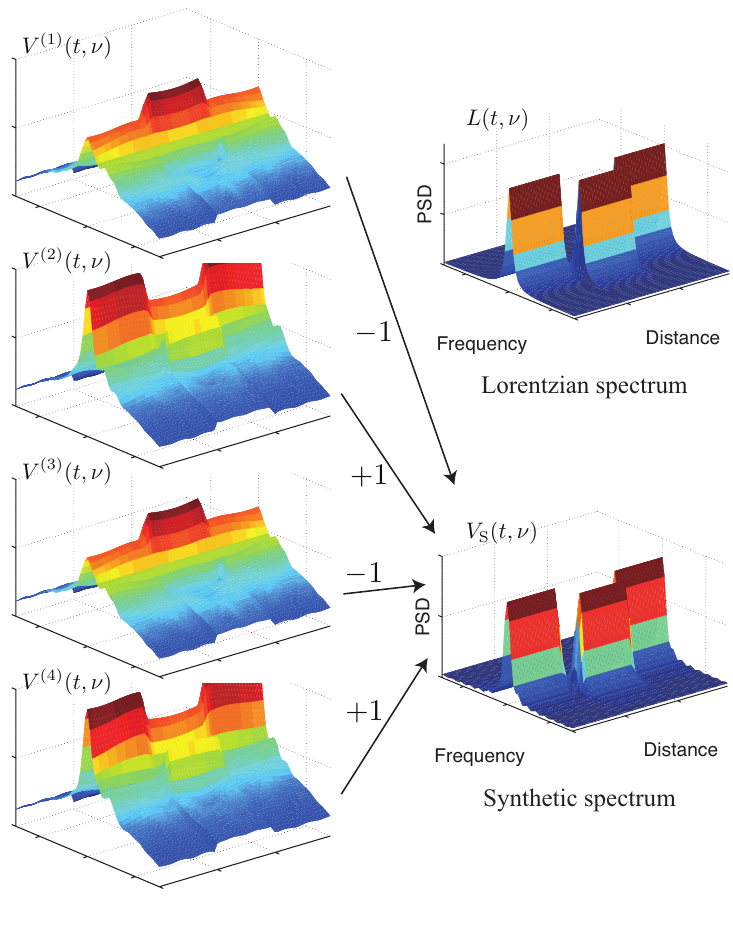
Figure 7. Composition of the synthetic spectrum of